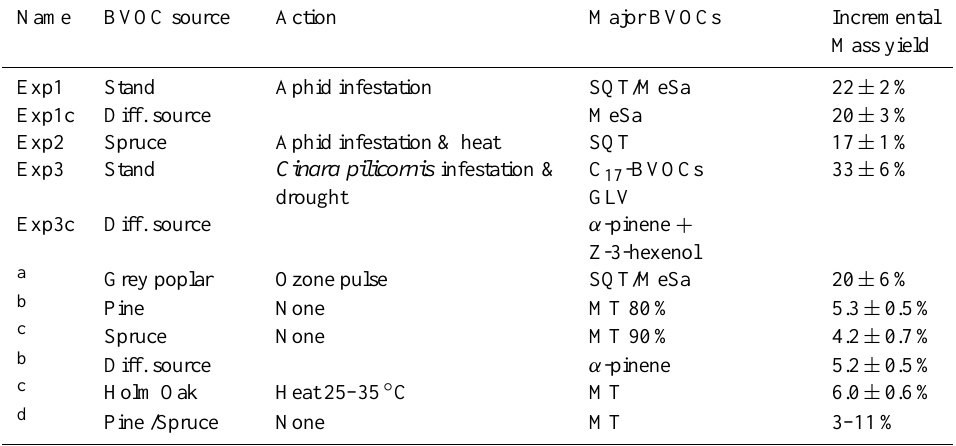
Table 4. Overview over incremental BSOA mass